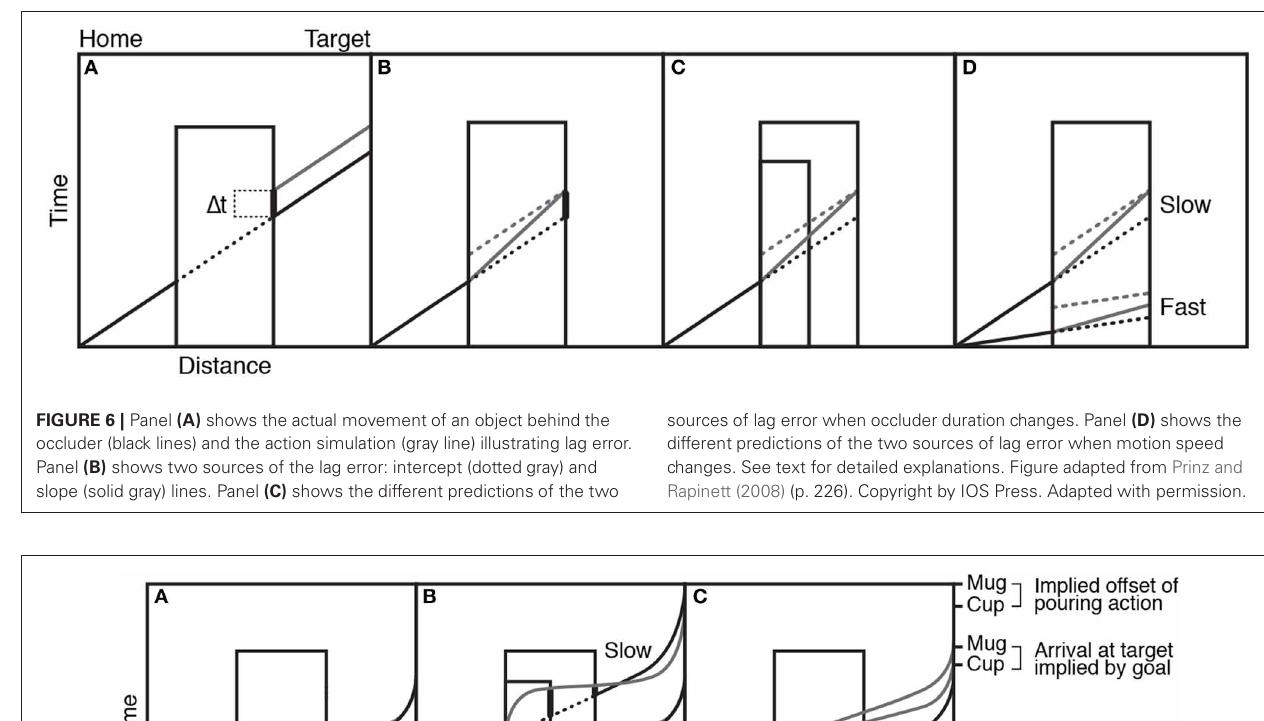
FIGURE 7 | Panel (A) shows the velocity profile of the action as it accelerates from the start and decelerates at the target (black solid line) with the occluded portion dotted. The regenerated action simulation is shown in gray. Panel (B) shows how this regenerated simulation